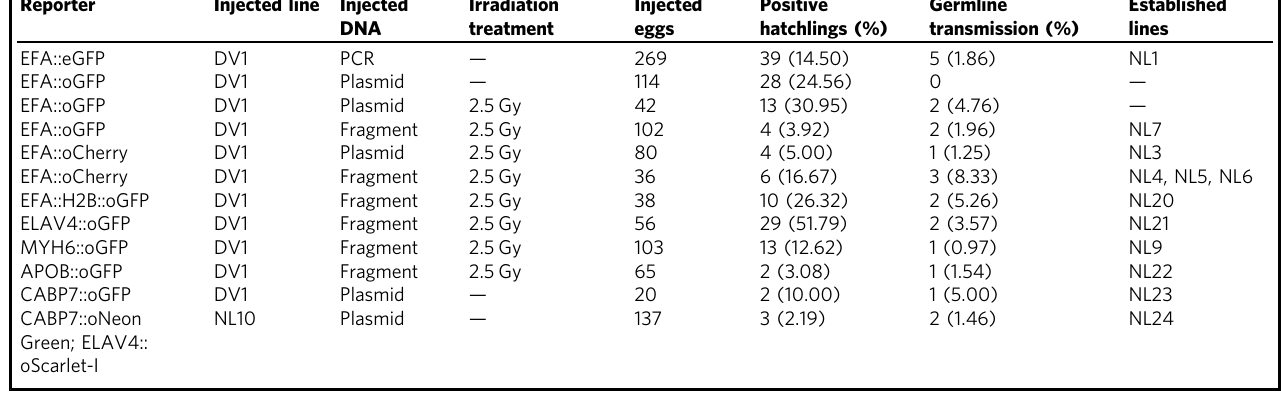
Table 1 Ef fi ciency of transgenesis with different reporter constructs and treatments Reporter Injected line Injected DNA